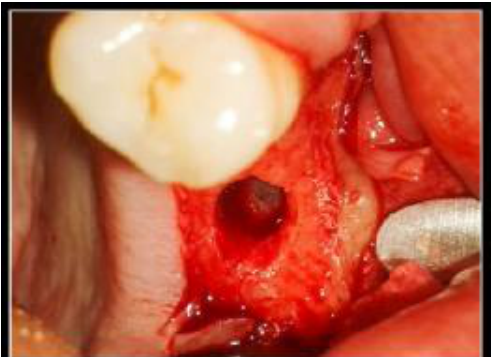
Figure 4: Schneiderian Membrane Clinically Visible of Two-Stage Sinus Lift Surgery with Subantral Bone Height of 3 mm.